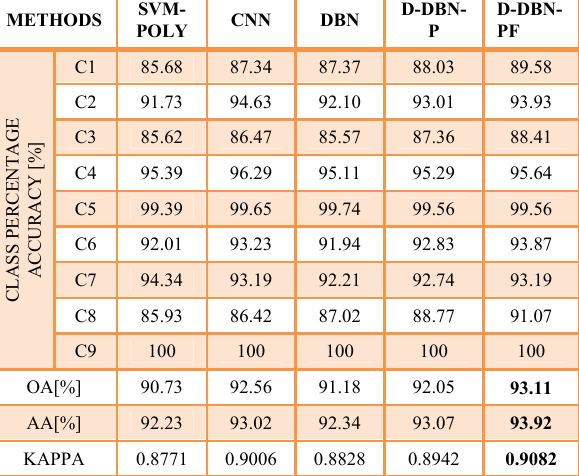
Table 3 Classification accuracies of different methods. 1) Comparison to SVM. SVM-based method can be deemed as the benchmark ‘shallow’ hyperspectral image classification method. SVM-based method was trained and tested on same training and test data sets with the sizes presented in Table